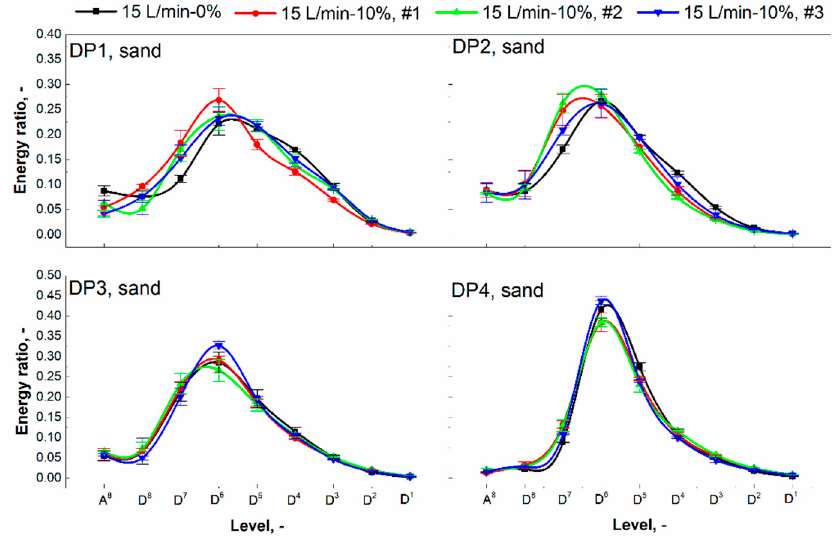
Figure 14. Effects of the gas extraction location on the energy distribution profiles of multi ‐ scale resolved differential pressure from DP1~DP4. The other operational conditions were: T = 550 °C, P = 0.1 MPa, H ini = 1.28 m, U = 0.09 m/s, extraction rate = 1.5 L/min, silica sand.